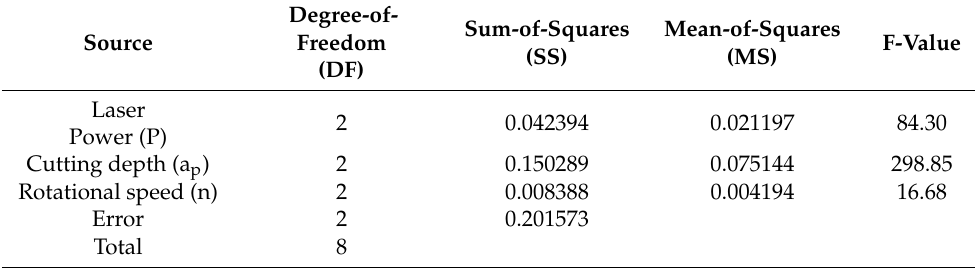
Table 5. Analysis of variance of surface